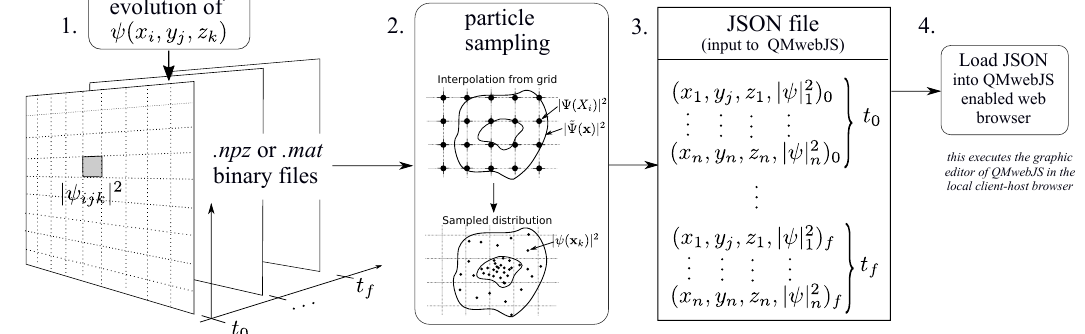
Figure 1. Steps of the data workflow for using